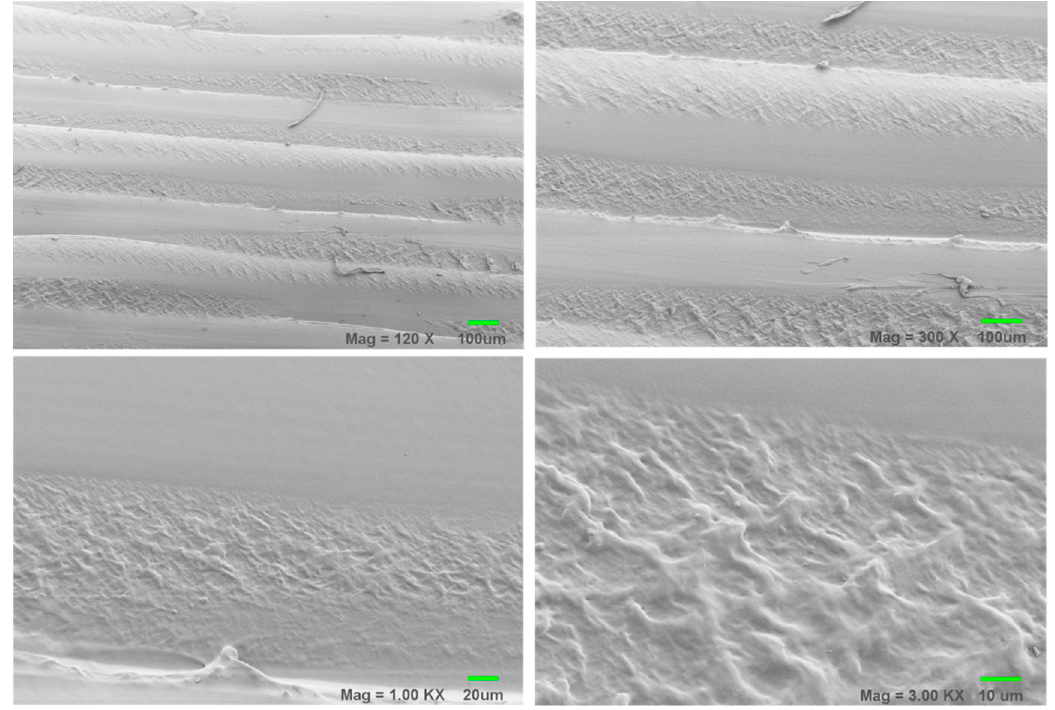
Figure 2. Scanning electron microscopy image of printed PLA showing micro ‐ and sub ‐ micron ‐ scale roughness.